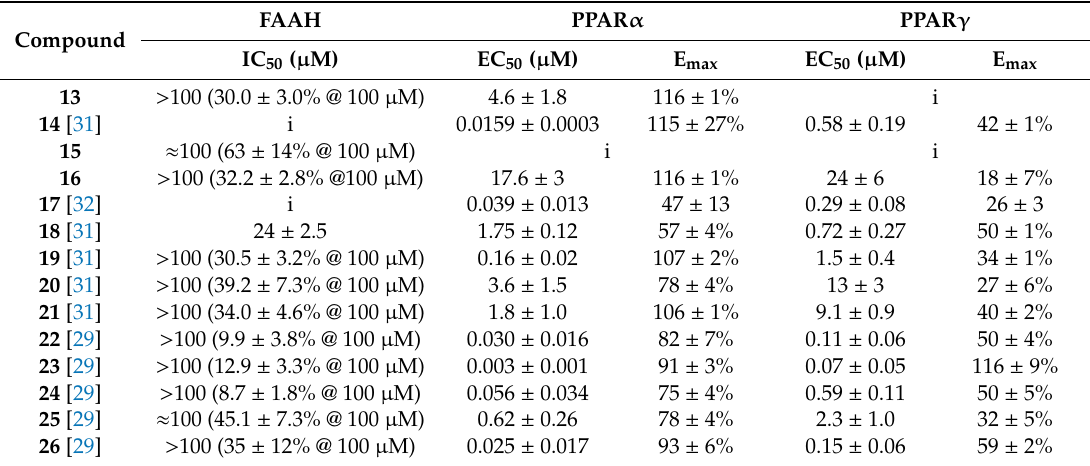
Table 2. Biological activities of phenoxyacetic compounds 13 – 26 . i: inactive. Compound